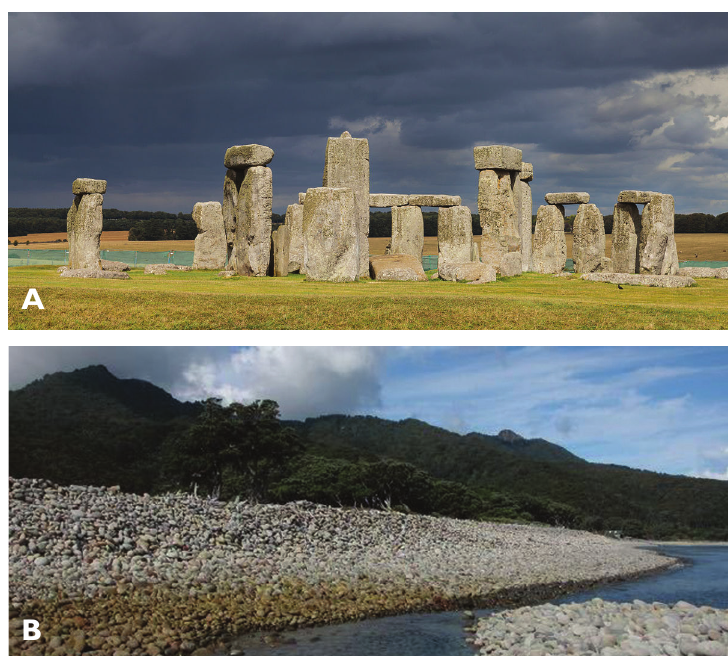
Figure 1. Human-mediated dispersal and natural colonisation: are they that different? A Stonehenge and B a rocky shore were both created by rolling stones, but they are quite different in origin and these differ- ences are important. A is courtesy of Diego Delso, under the CC BY-SA 4.0 licence, https://commons. wikimedia.org/w/index.php?curid=35323153); B is courtesy of Tim